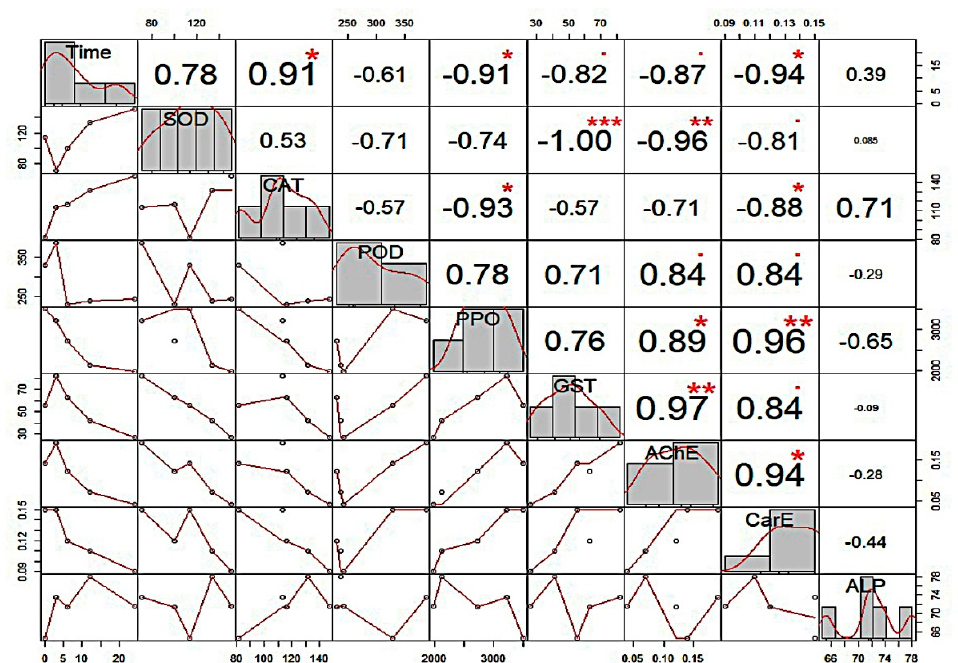
Figure 3. Pearson correlation matrix of UV − light exposure time and Plutella xylostella larvae enzyme activity. The distribution of each variable is shown on the diagonal. The bivariate scatter plots with a fitted line are displayed on the bottom of the diagonal. The correlation value and the significance level as stars are on the top of the diagonal. Each significance level is associated to a symbol: P - values (0, 0.001, 0.01, 0.05, 0.1) < = > symbols (“***”, “**”, “*”, “.”, “ ”).